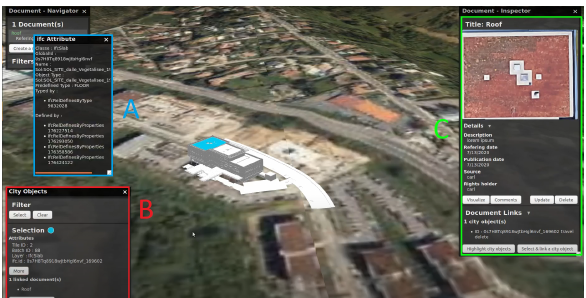
Figure 8. Contextual view of a building of a slab constructed using : a spatial representation as 3D geometry in blue from an Ifc file, and thematic information coming from an Ifc file (in frame A), the geometry (in frame B), documents (in frame